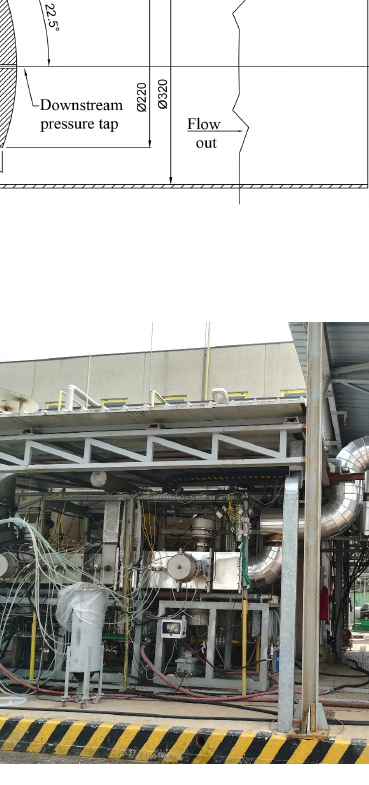
Figure 4. Piping system equipping the tested flowmeters.